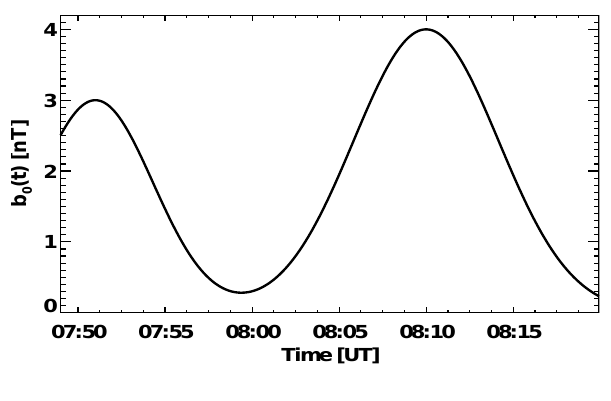
Fig. 10. Temporal development of the wave amplitude b 0 (t)